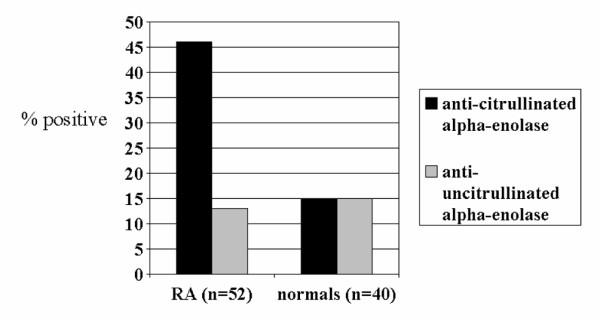
Prevalence of antibodies against deiminated and undeiminated α-enolase in RA patients and healthy controls. Immunoblotting of in vitro citrullinated and untreated α-enolase with serum samples from patients with rheumatoid arthritis (RA) and normal controls, showing that about half of the serum samples from the RA group contain antibodies with selectivity for citrullinated α-enolase.